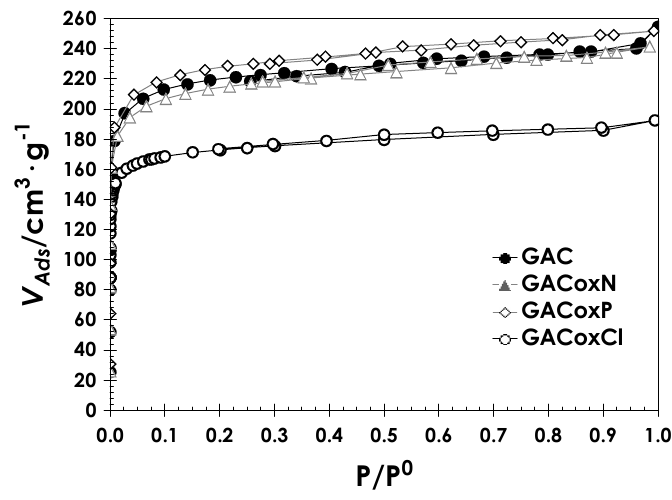
Figure 2. N 2 adsorption–desorption isotherms at − 196 °C, for all the activated carbon set.